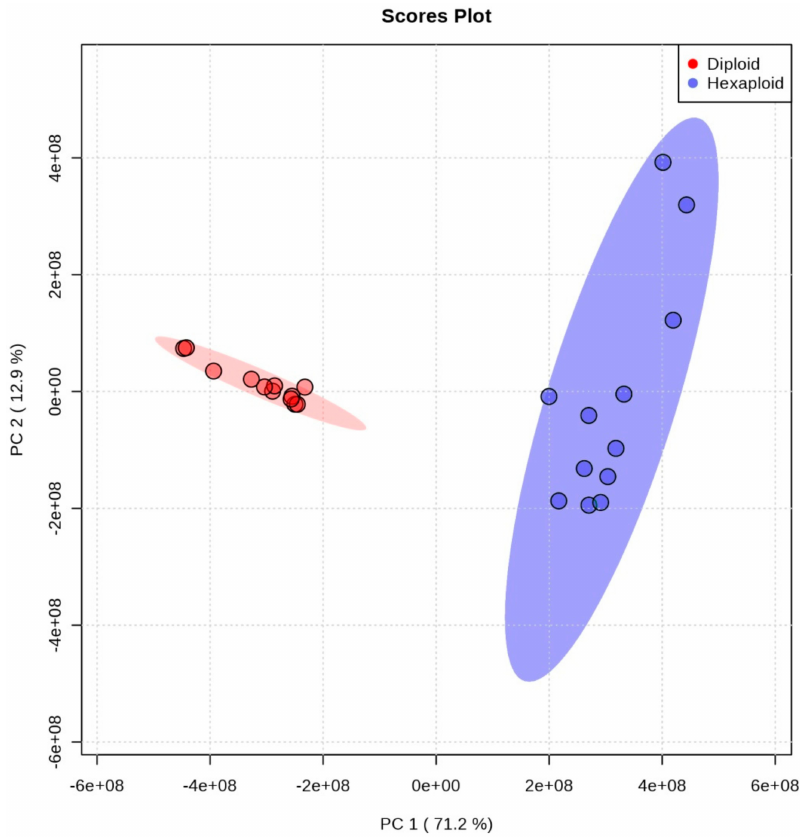
Figure 1. The PCA analysis of metabolites between two cytotypes of S. canadensis